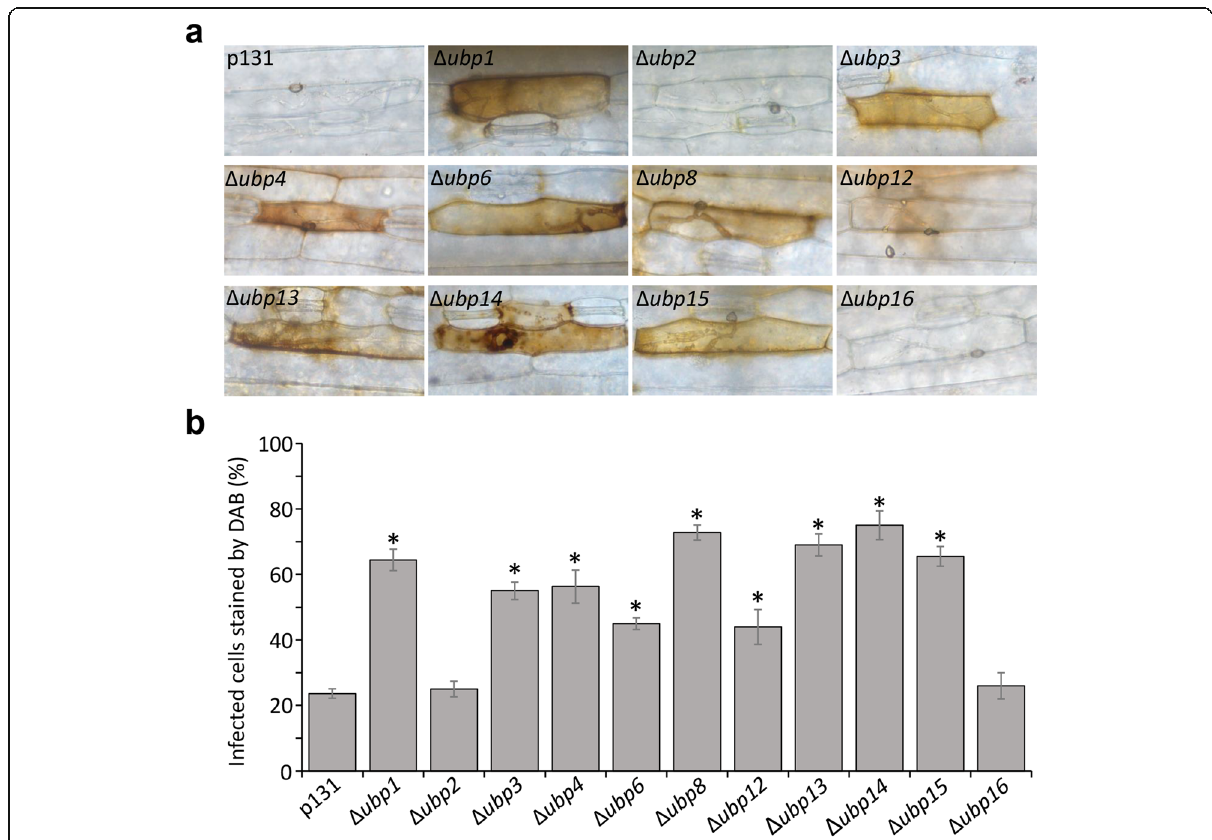
Fig. 7 Detection of the host cell ROS accumulation. a DAB-staining assays of the wild type and ubp mutants-infected barley epidermis cells. b Percentage of DAB-stained barley epidermis cells infected by the wild-type and ubp mutant strains. Means and standard errors were calculated from three independent replicates. Significant differences were indicated by asterisks ( P < 0.05)